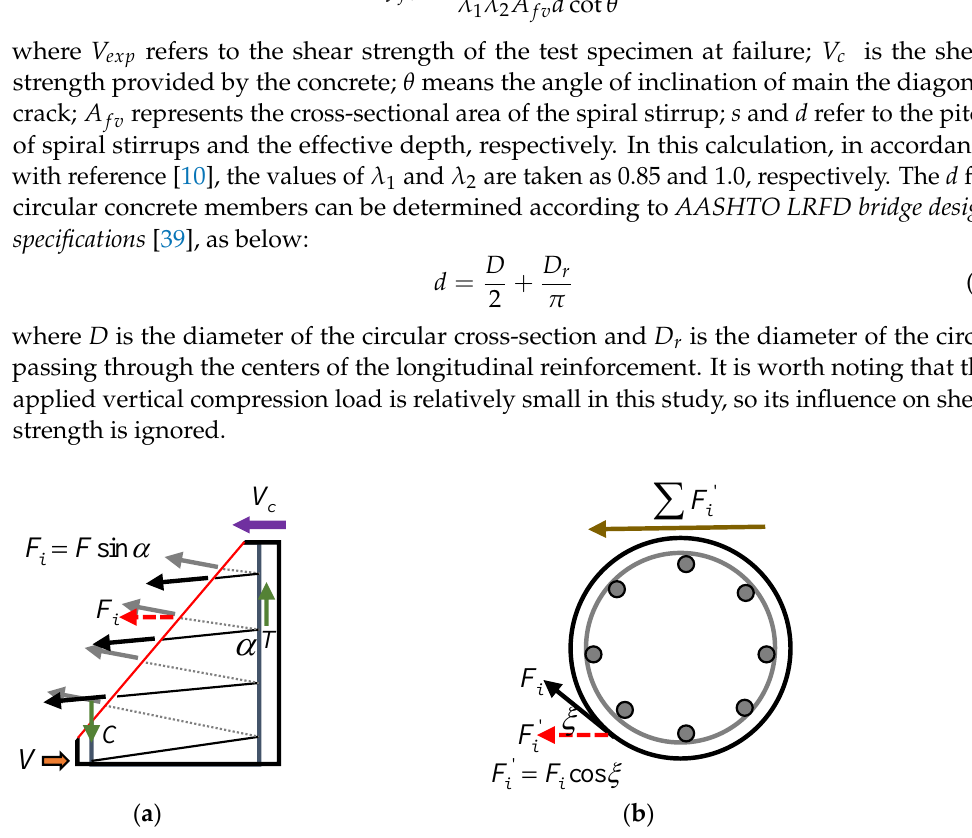
Figure 22. Shear transfer mechanism of a circular column with spiral stirrups. ( a ) Front view; ( b ) Top view.